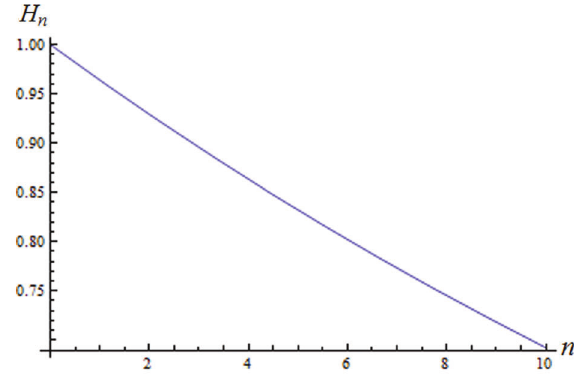
Figure 4. System time response for the standard diet group.